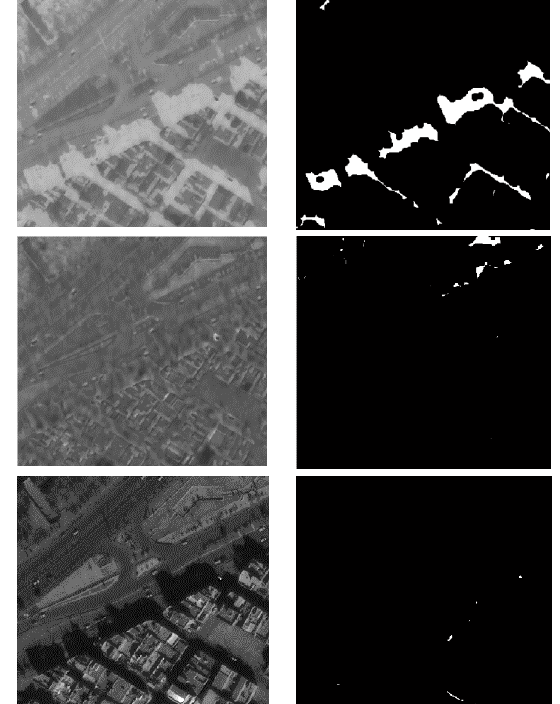
Figure 5. Result of computing indices (left) and Otsu thresholding (right) for C3New (top), NDVI (middle) and SBI (bottom) 4.3 3 rd step: Object-based and pixel-based shadow detection Ground truth information are used by supervised machine learning algorithms to separate shadow and non-shadow pixels. To detect shadow areas in object level, a majority voting analysis is used on number of shadow pixels in each image objects. To solve the ambiguity between vegetated and shadow objects an extra condition is checked to confirm that an object belongs to shadow class. This condition uses the mean NDVI value of pixels in each image object. For shadow objects the NDVI should have low values. The result of detecting shadows on pixel level using SVM algorithm, shadow detection on object level and overlay of shadow areas on original image is presented in Figure 6.visually the superiority of the object- based shadow detection results is clear and in evaluation step it will be